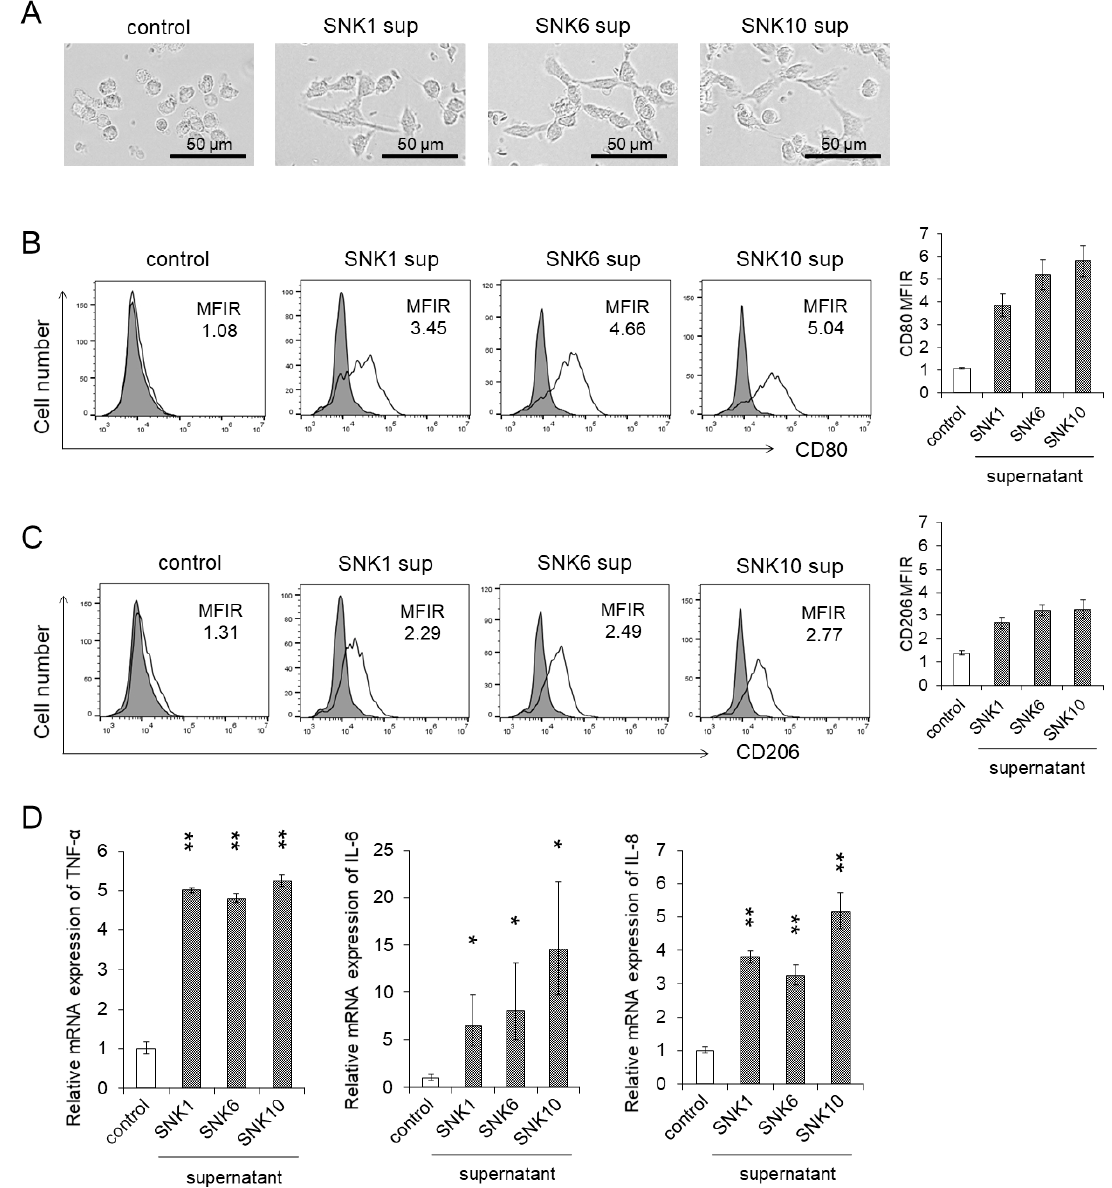
Figure 2. The differentiation of human monocytes to macrophages and activation were promoted by the supernatants of EBV-positive NK-cell lines. Human monocytes were co-cultured with each supernatant of EBV-positive NK-cell lines for 24 h. The same amount of culture media of EBV-positive NK-cell lines was added as an untreated control. After the co-culture, the target cells were subjected to each assay. ( A ) A representative morphology of human monocytes was pictured using an optical microscope. ( B , C ) The CD80 and CD206 expression on human monocytes was determined by flow cytometry. The representative figure is shown on the left panel indicating CD80 and CD206 (open histogram) or isotype-matched control (gray, shaded histogram). The mean fluorescent intensity of CD80 and CD206 was normalized by that of isotype-matched control and expressed as MFIR. ( D ) The mRNA expression of TNF- α , IL-6 and IL-8 in human monocytes was analyzed by qRT-PCR assay. The expression was normalized to GAPDH mRNA. The data are shown as the mean ± SD of three independent healthy donors ( n = 3). Significant differences are indicated as * p < 0.05 and ** p < 0.01 compared to the